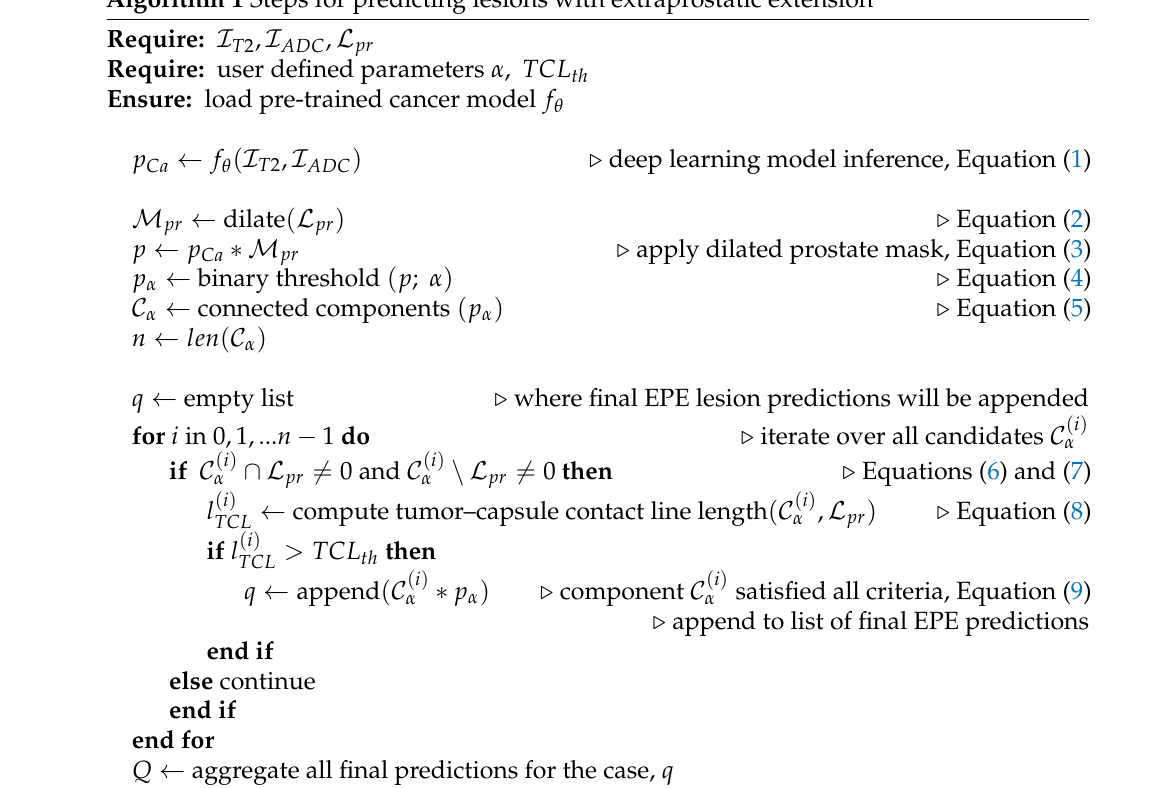
Algorithm 1 Steps for predicting lesions with extraprostatic